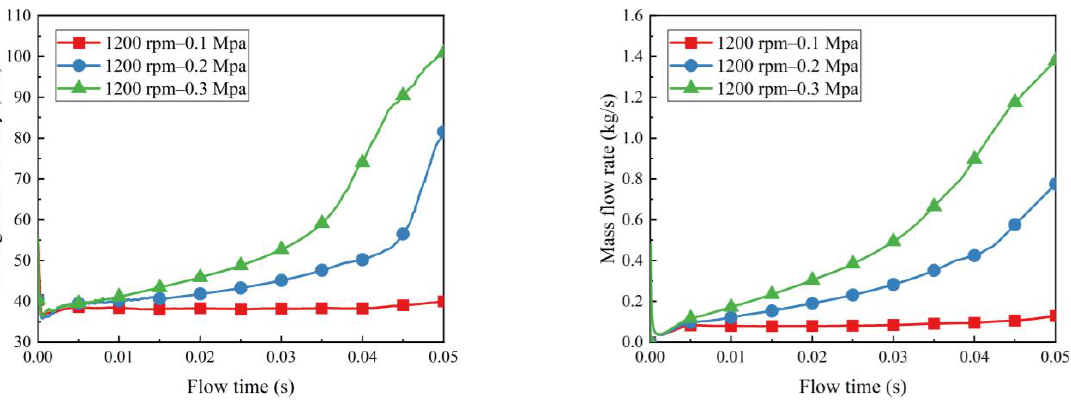
Figure 14. Variation of average flow velocity at variable pressure ( left ) and mass average flow velocity ( right ).